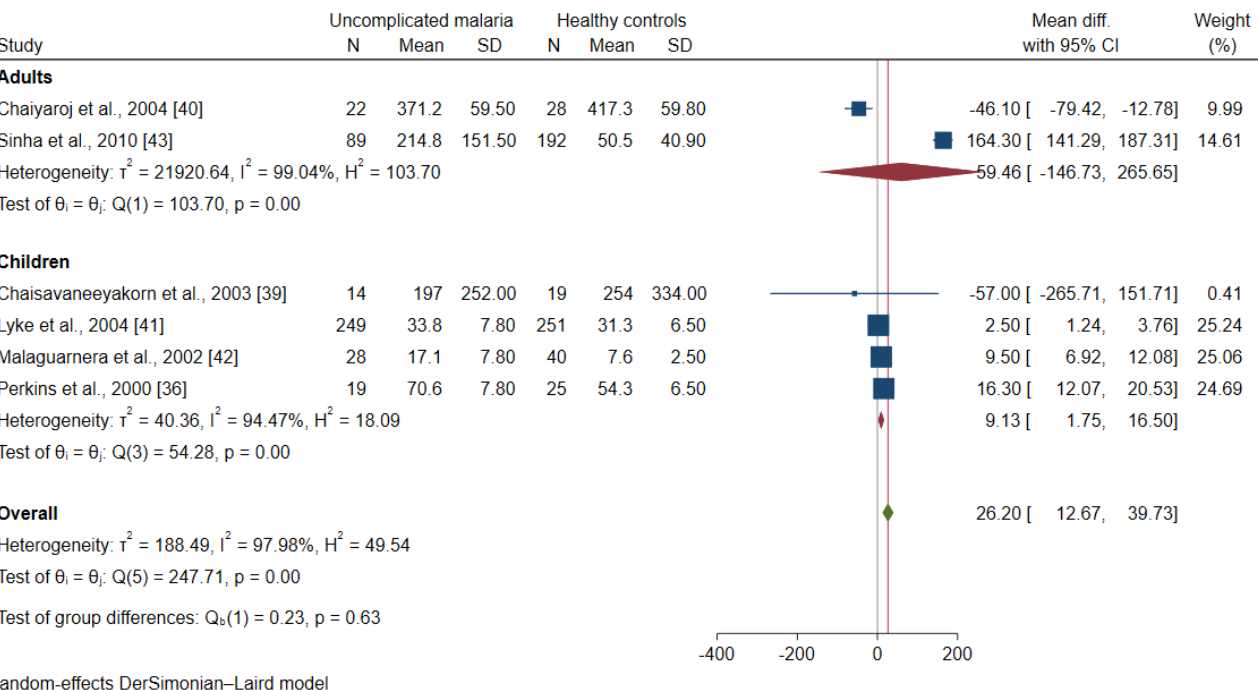
Figure 6. Forrest plot demonstrated the difference in the mean IL-12 levels (pg/mL) between patients with uncomplicated malaria and healthy controls by continents [36,39–43]. Abbreviation: Mean Diff., mean difference; CI, confidence interval. Explanation of the forest plot: squared-box symbol, point estimate; green diamond and red line: pooled mean difference: red diamond: pooled mean difference in each subgroup; blue line: line of no effect; I 2 , level of heterogeneity; p = 0.00 or less than 0.05, significant heterogeneity.